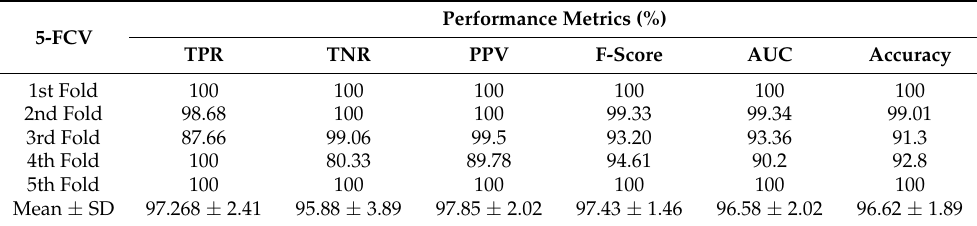
Table 10. Classification performance of the proposed model on RMSProp optimizer.